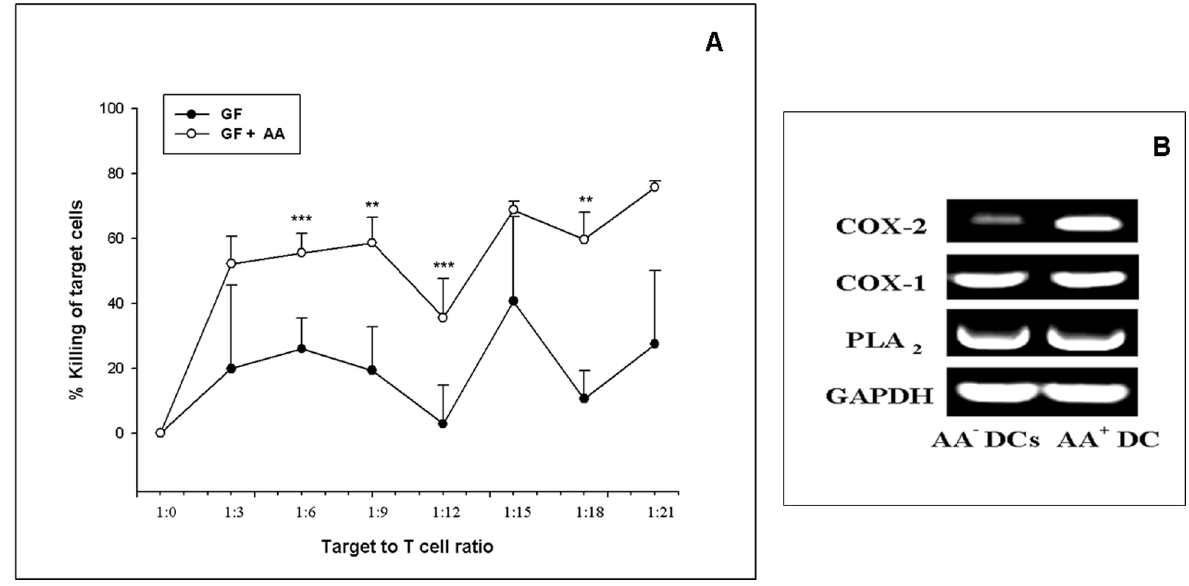
Figure 5. CTL and Transcript levels of key enzymes in AA + DCs and AA - DCs. (A) CTL data of one representative sample i.e. killing of the target (MCF-7) cells by CTLs generated by AA + DCs/AA - DCs pulsed with MCF-7 cell lysate. CTLs derived from AA + DCs exhibited an improved effector function i.e. enhanced overall killing as compared to CTLs derived from AA - DCs. The killing is significantly higher at four ratios of effector target cell concentrations. (*P # 0.05, **P # 0.01, ***P # 0.001). (B) Gene expression profile of three key enzymes associated with AA pathway along with the housekeeping gene GAPDH. There is a substantial up-regulation of transcript level of key enzyme COX-2 in the DCs cultured in presence of AA.